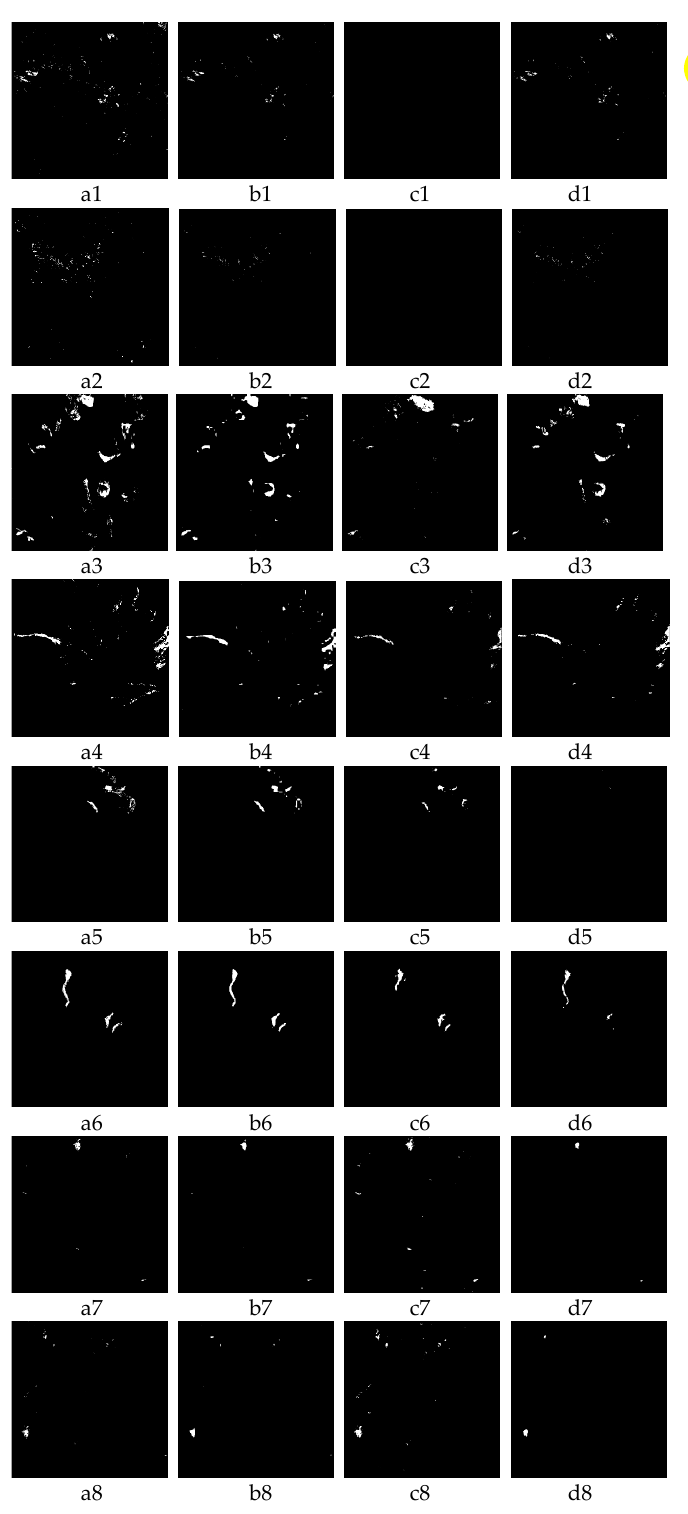
Figure 10. Landslide detection results of two test samples in each dataset: the images in column (a) indicate ground truth images of landslides, labeled as white, and background objects are labeled as black; the images in column b–d demonstrate the detection results by our two-branch Matrix SegNet, SegNet, and U-Net, respectively; indexes (*).1–(*).2 represent the test images in Lushan; indexes (*).3–(*).4 represent the test images in Jiuzhaigou; indexes (*).5–(*).6 represent the test images in Nepal and indexes (*).7–(*).8 represent the test images in Taiwan, * indicates